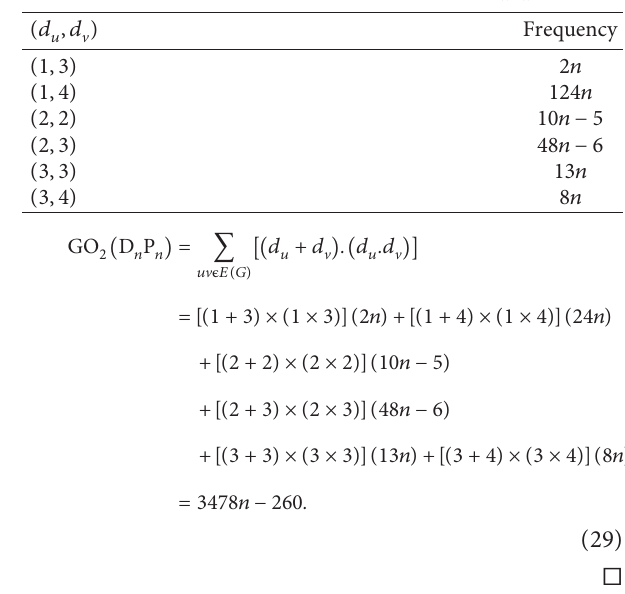
Table 7: Degree-based edge partition of D